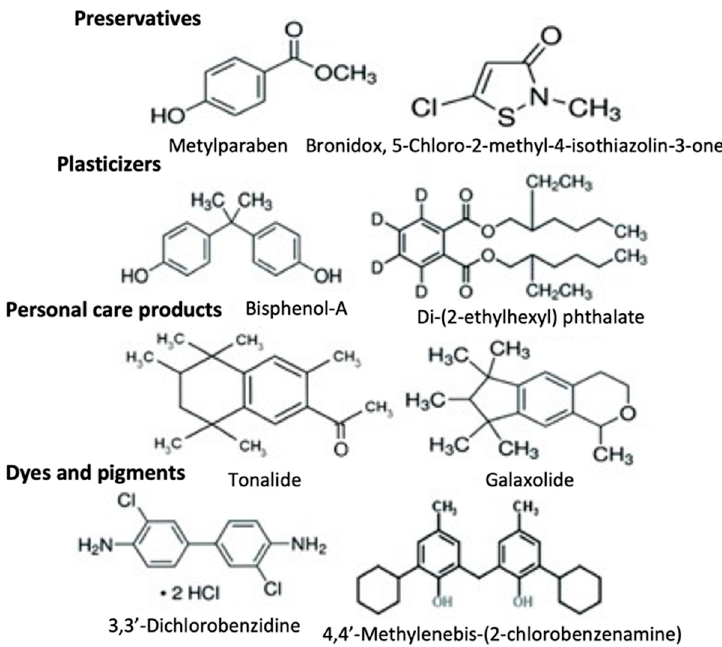
Figure 2. Structure of some xenobiotics (Reproduced with permission from [24]; published by Springer eBook, 2019).